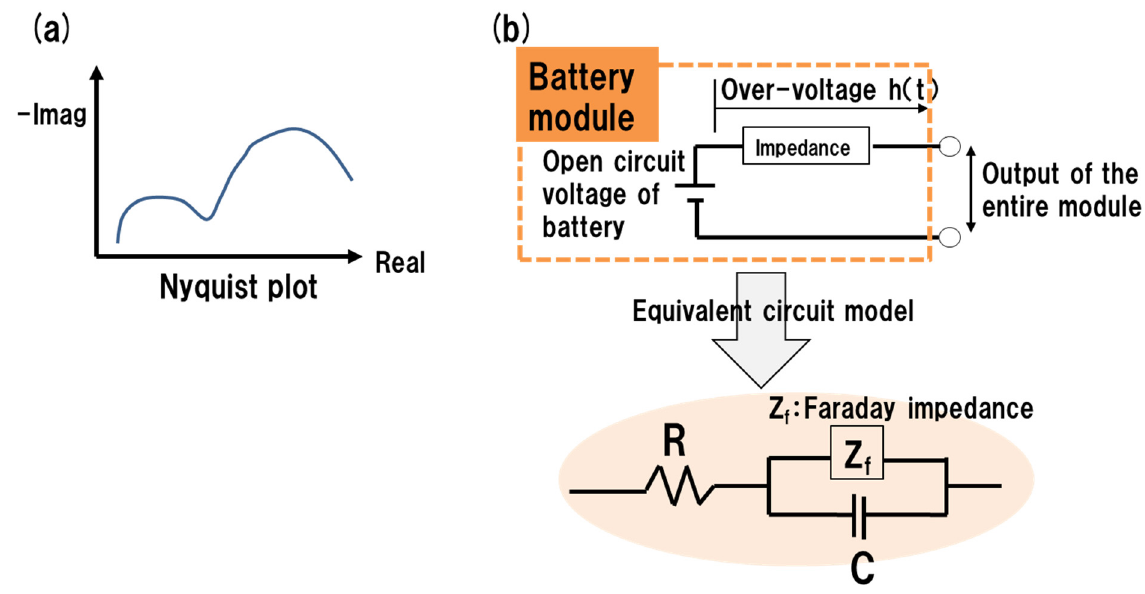
Figure 1. Derivation of the overvoltage η ( t ) using the equivalent circuit of the battery. ( a ) Nyquist plot from impedance measurement. ( b ) Equivalent circuit model of battery module.